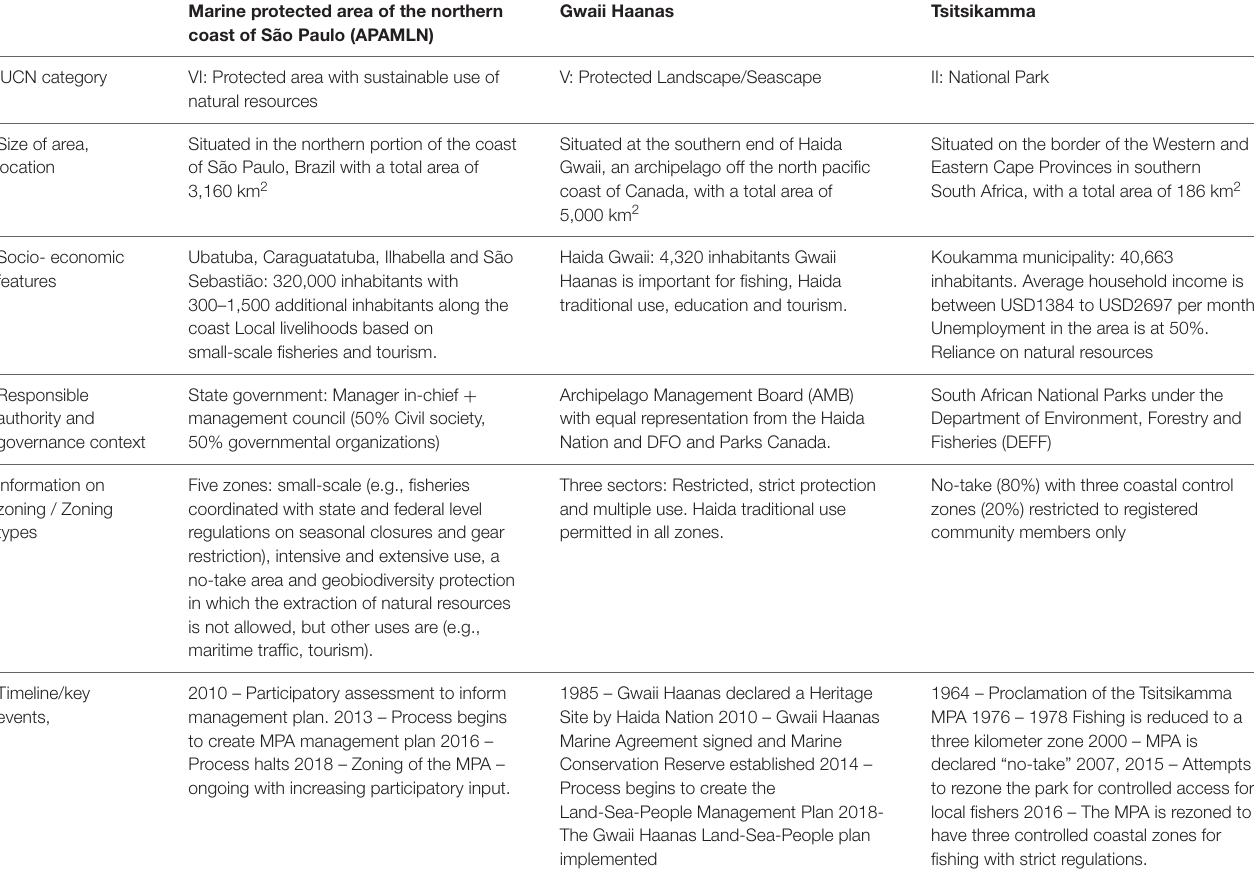
TABLE 2 | Overview of case study